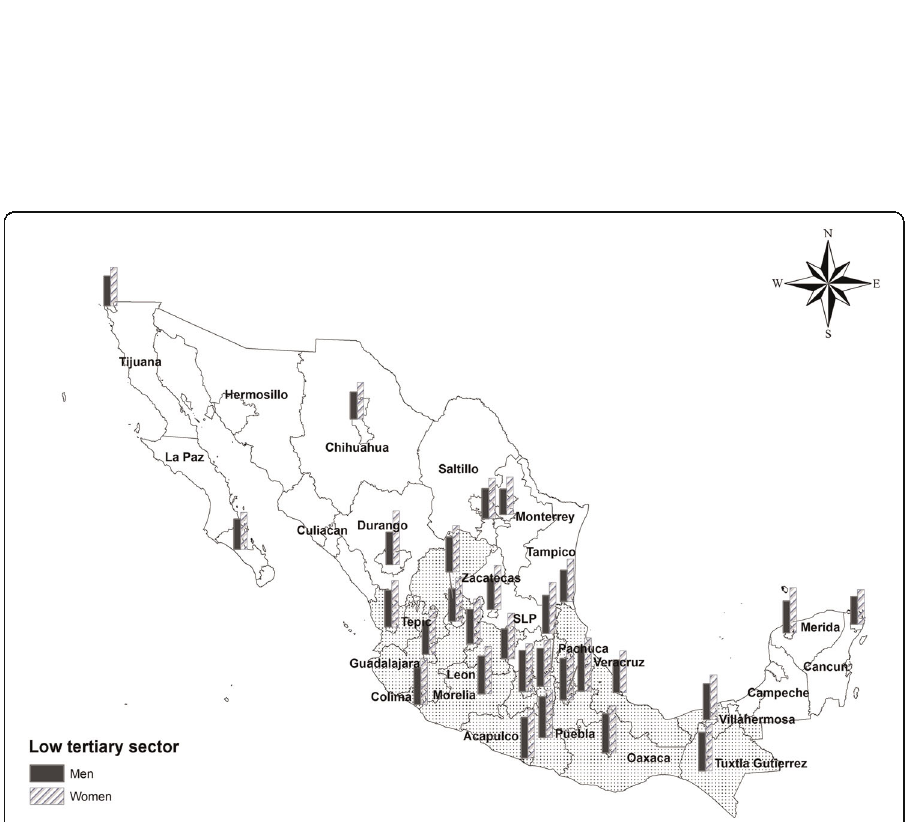
Fig. 4 Precariousness in the low-tertiary sector, 2018. Source: Author ’ s extrapolation with data from the